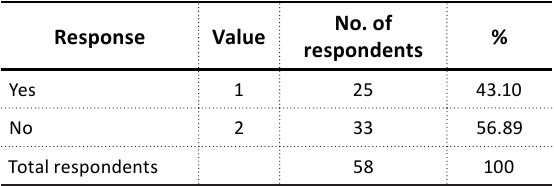
Table 7. Q1: Are you aware of any specifictargeted development programs aimed at women?